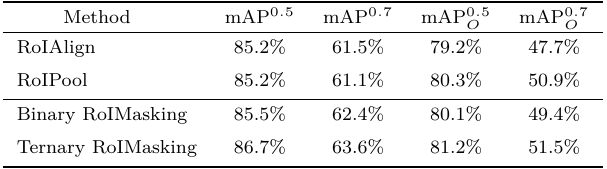
case in which the values in the yellow area of Fig. 5(d)